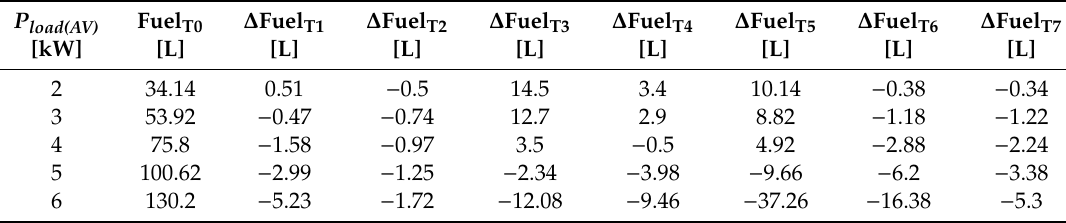
Table 7. Fuel economy for k fuel = 50 and di ff erent P load(AV)